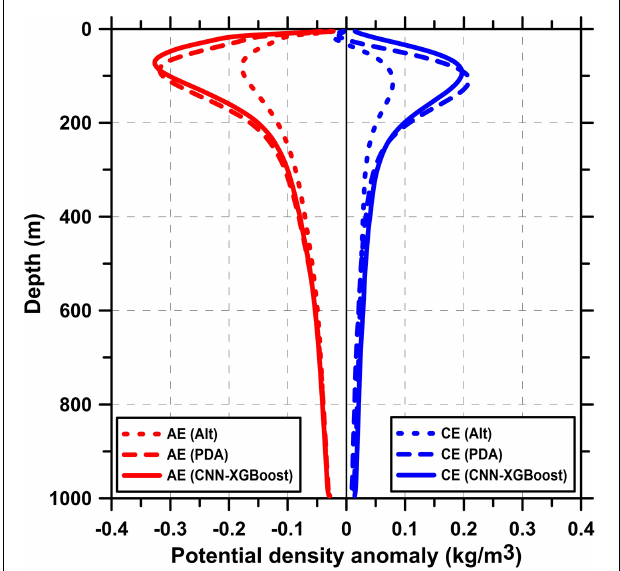
FIGURE 5 | Global mean potential density anomaly profiles for different types of eddies from 2002 to 2019. The short dashed line is the profile of Alt-eddy. The long dashed line is the profile of potential density anomaly (PDA) eddy and the solid line is the vertical structure that is inside eddies through the convolutional neural network with extreme gradient boosting (CNN-XGBoost) model but not recognized by the altimeter. Red lines represent anticyclonic eddies (AE), and blue lines are cyclonic eddies